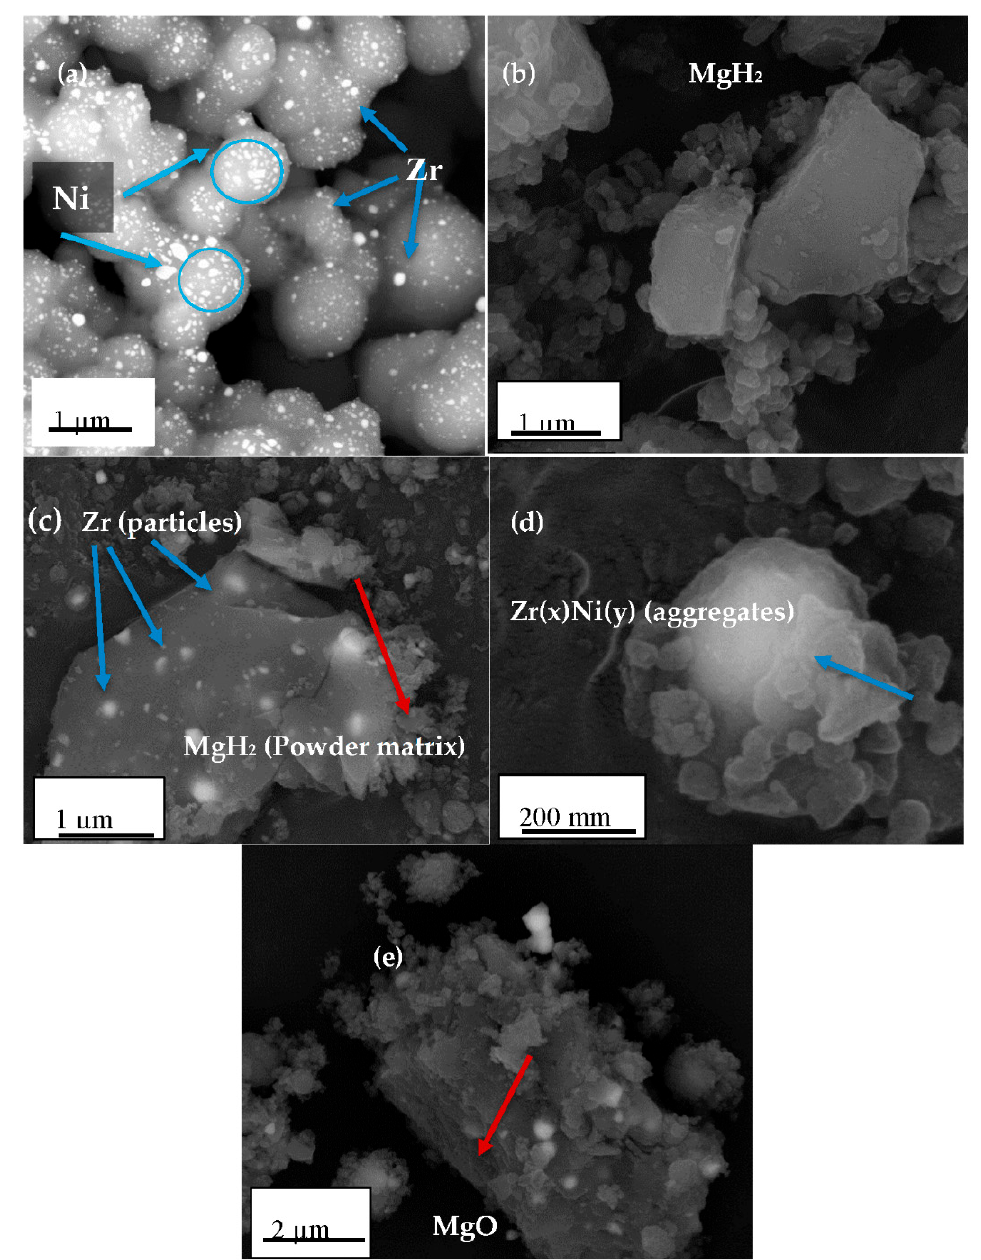
Figure 6. SEM micrograph of ( a ) Zr (x) Ni (y) based nanocatalyst after 5-h heat treatment under hydrogen; ( b ) MgH 2 after 5 h milling time under argon, here used for reference; ( c – e ) MgH 2 / 10 wt.% Zr (x) Ni (y) nanocomposite. The homogeneous distributions of the Zr (x) Ni (y) on the MgH 2 surface are shown in ( c ). The enlarged image of the MgH 2 / 10 wt.% Zr (x) Ni (y) showing the aggregation of Zr (x) Ni (y) is represented in ( d ) and the presence of MgO is represented in ( e ).